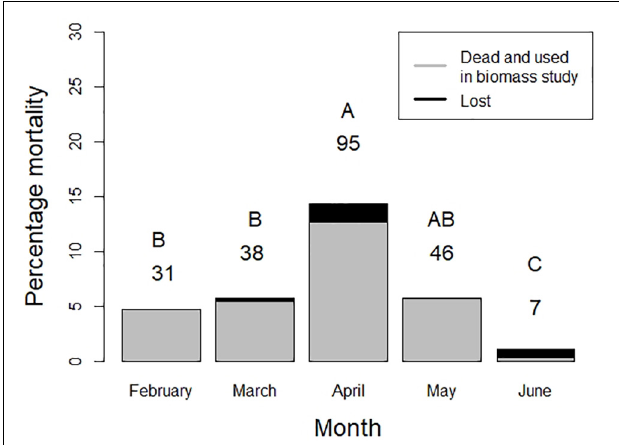
FIGURE 3 | Causes of seedling mortality: this includes individuals with no obvious cause of death and were used in biomass allocation estimate, and “lost” refers to individuals where the entire plant was gone; letters show significant differences as result of repeated measures ANOVA.